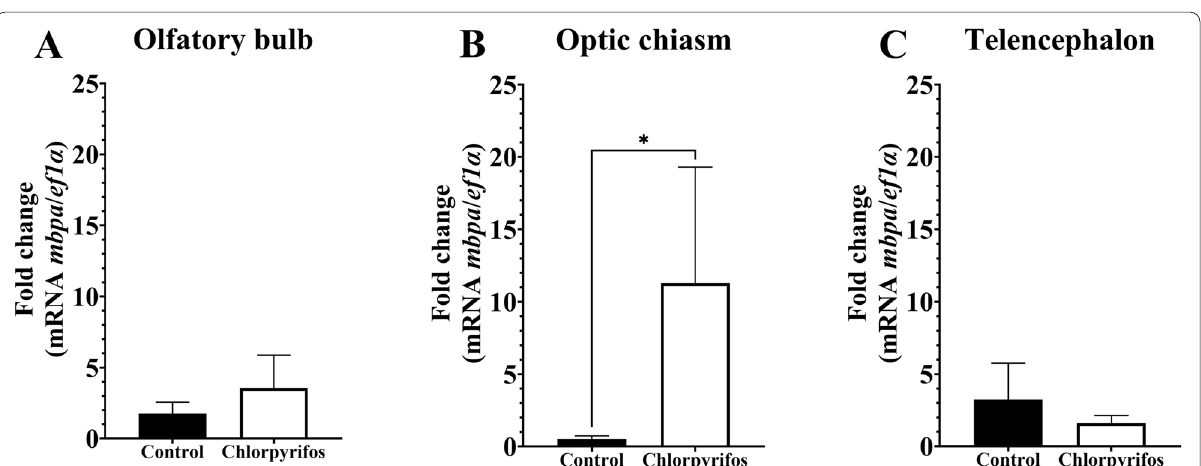
Fig. 4 Relative gene expression of mbpa transcripts in Piaractus brachypomus after an exposition to Chlorpyrifos (0.011 μg/L). A mbpa levels in the olfactory bulb; B mbpa levels in optic chiasm; C mbpa levels in telencephalon. ef1a was used as a reference gene. * p <